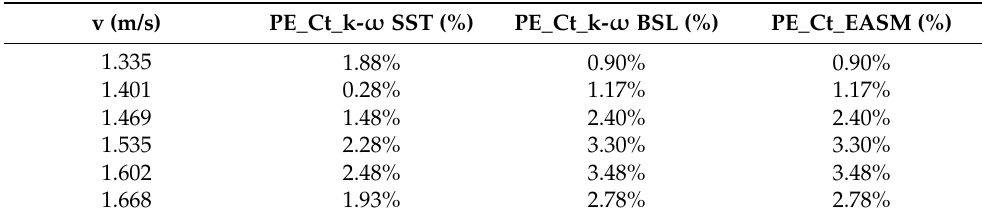
Table 5. Percentage error between experimental test and CFD simulation with SHIPFLOW for To- tal Resistance Coefficient (Ct).